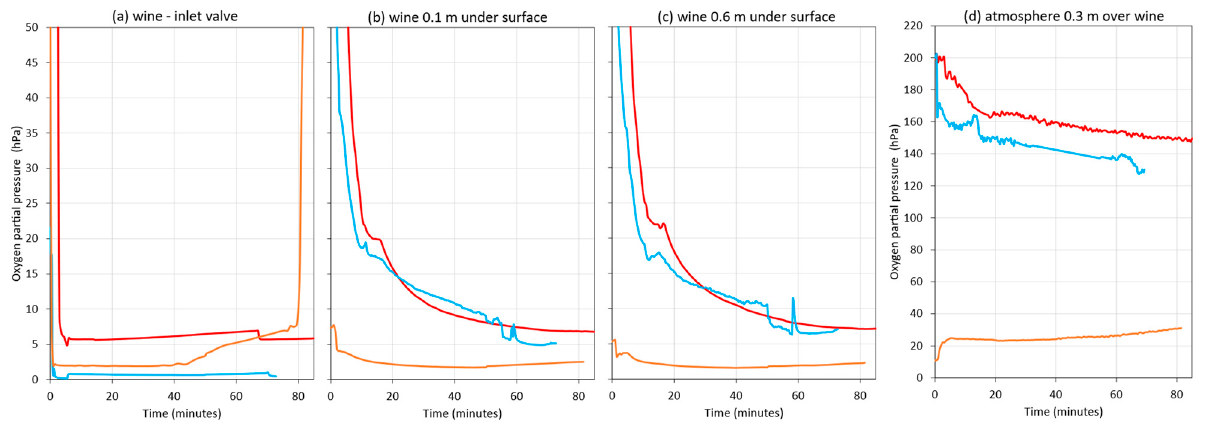
Figure 13. Oxygen content in the 25,000 L destination tank during a white wine racking in a commercial winery (Bodega Emina, Medina del Campo, Spain). Without inerting (red), using nitrogen as inerting gas (blue) or argon (orange). Measures made in wine in the inlet valve ( a ); 0.1m depth inside the wine ( b ); 0.6m depth inside the wine ( c ) and in the atmosphere at 0.3m above the surface of the wine ( d ).